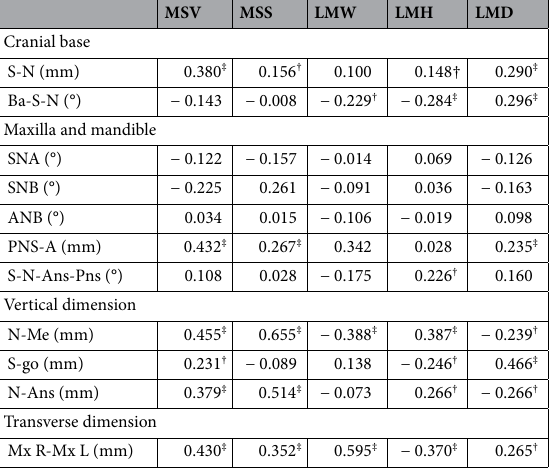
Table 7. Pearson’s correlation coefficients between MS measurements and cephalometric variables taken into consideration. A p value < 0.05 was considered statistically significant ( † p < 0.05; ‡ p <